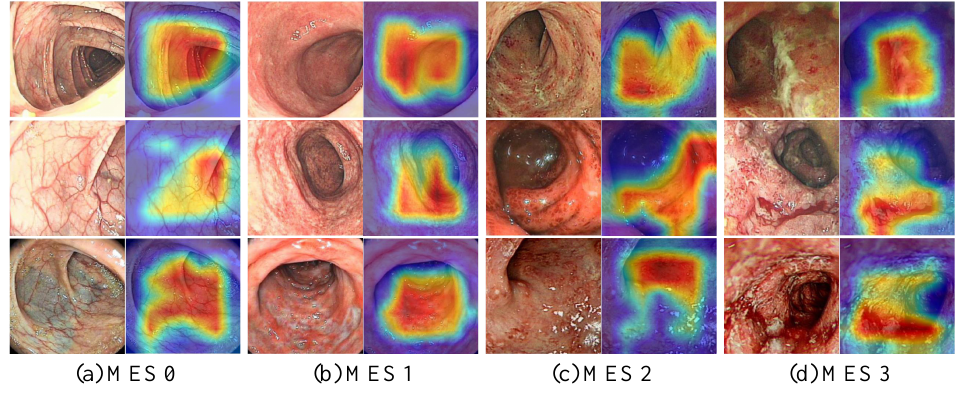
Figure 11. Visualization of the attention maps obtained by